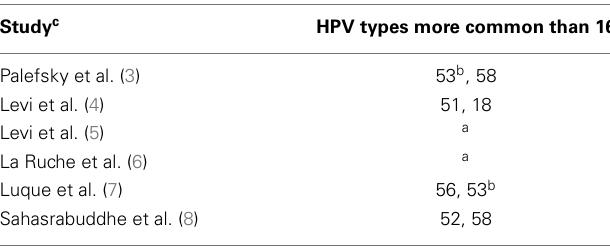
Table 1 | Common HPV genotypes in HIV-infected women – summary (2)